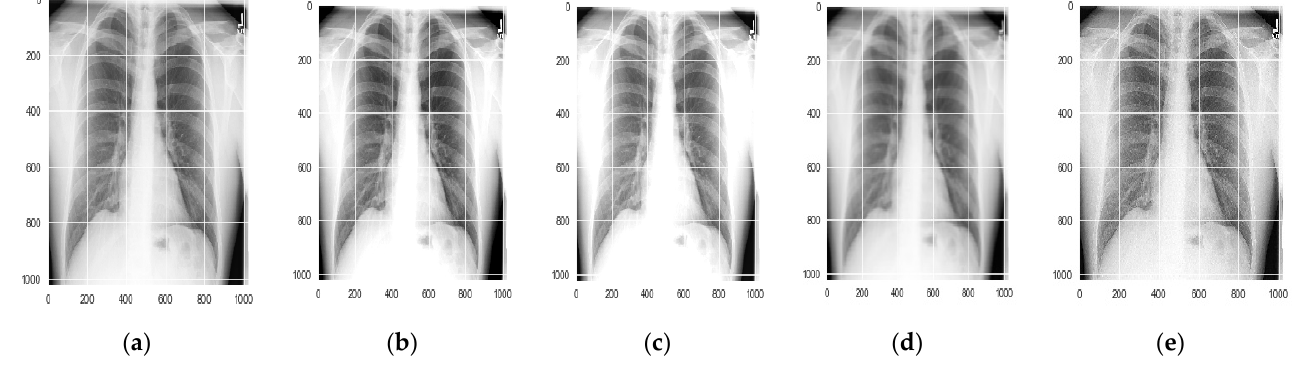
Figure 9. Augmentation applied to images; ( a ) original image ( b ) contrasted image ( c ) multiplied image ( d ) blurred image ( e ) sharpened image.